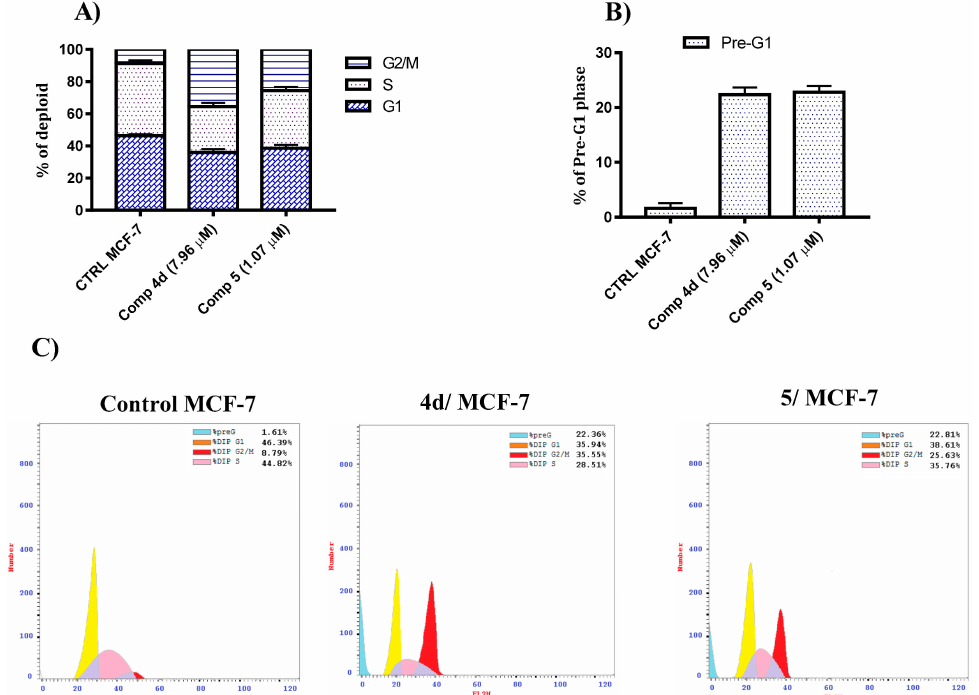
Figure 2. ( A ) A graphical representation of cell cycle analysis of compounds 4d and 5 against MCF-7 at their IC 50 ( µ M). ( B ) A graphical representation of the percentage of pre-G1 phase induced by compounds 4d and 5 against MCF-7 at their IC 50 ( µ M). ( C ) Cell cycle analysis of compounds 4d and 5 against MCF-7 at their IC 50 ( µ